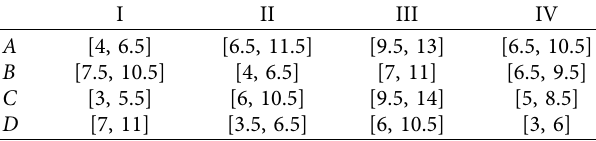
Table 14: Transformation of Table 10 at α � 0 . 5.